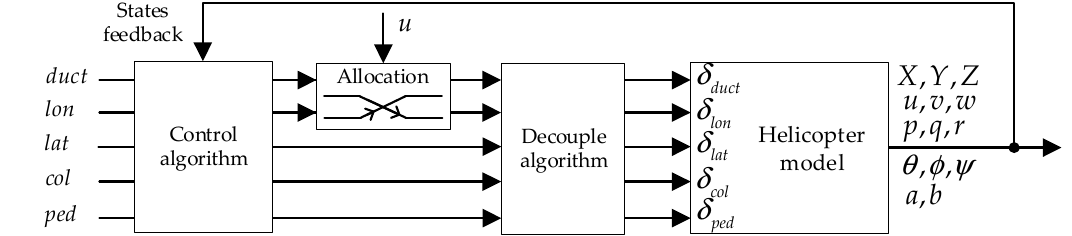
Figure 8. Control diagram in automatic flights.